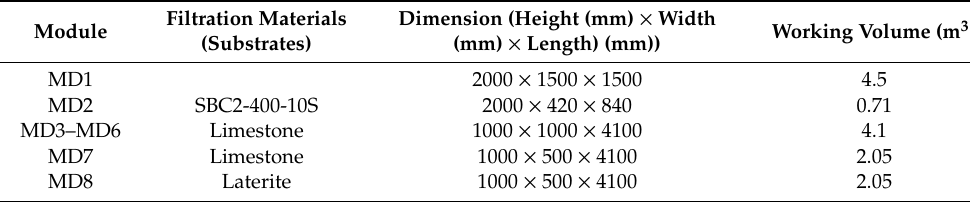
Table 2. Size parameters of modules of the treatment system. MD1: settling tank, MD2: adsorbent tank, MD3–MD8: constructed wetlands